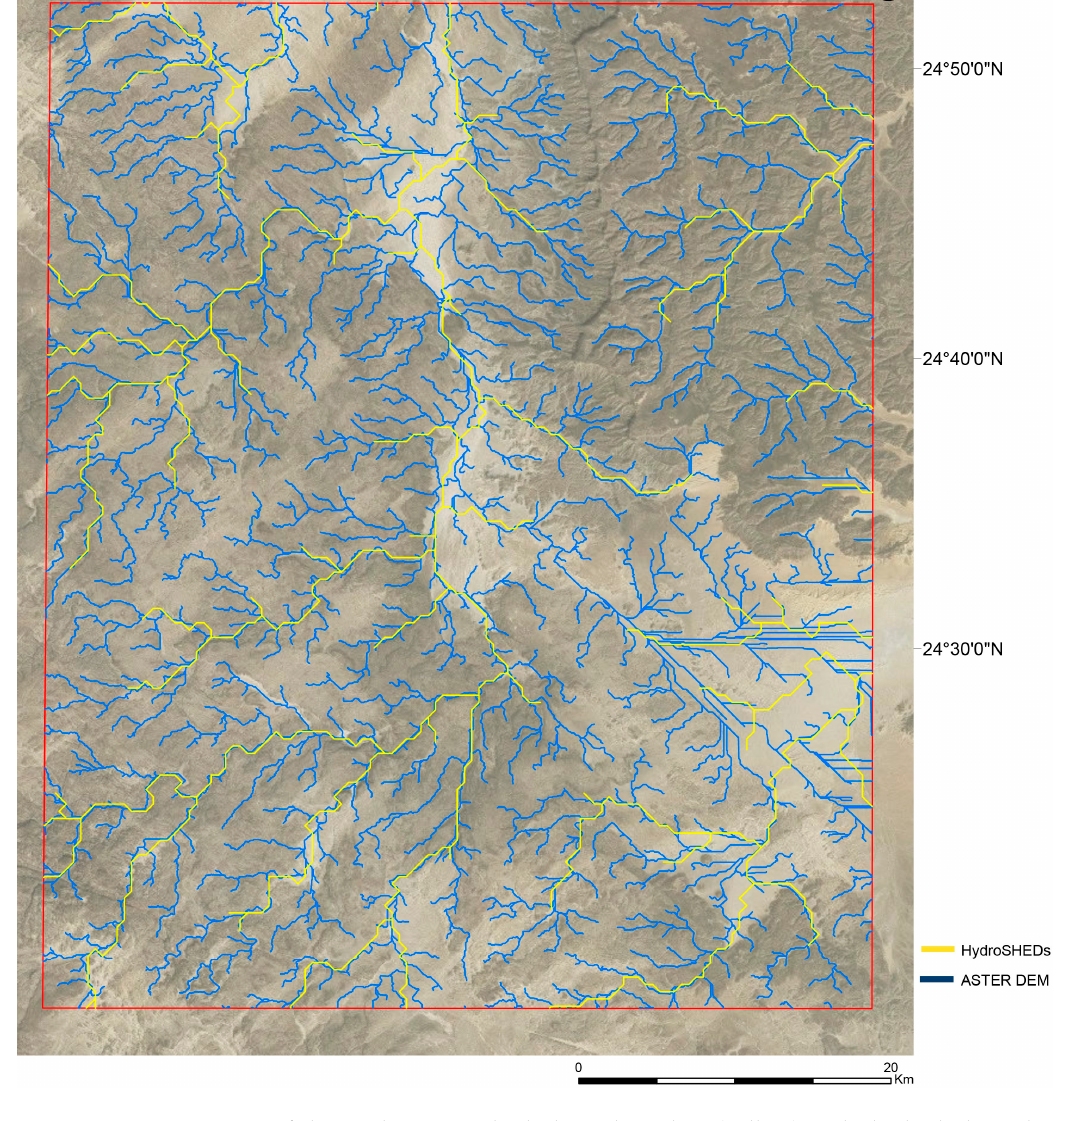
Figure 3. Comparison of the HydroSHEDS hydrological product (yellow) with the hydrological network derived from the ASTER DEM (using 1000 cells) (blue) used in this study.